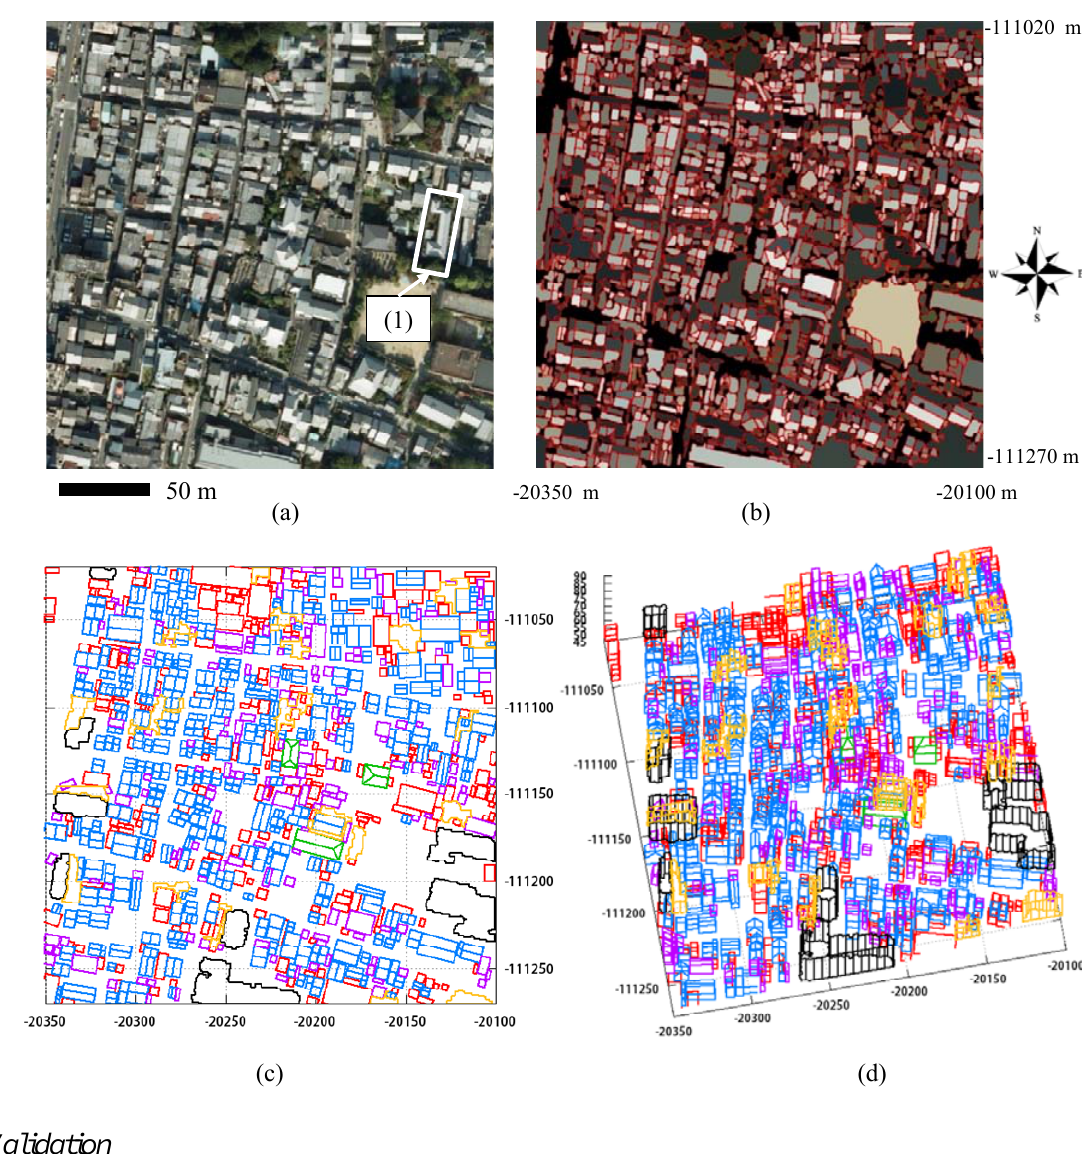
Figure 11. ( a ) Aerial image, ( b ) segmentation results, and ( c , d ) modeling results for an area containing low-rise buildings. Wireframe models are as in Figure